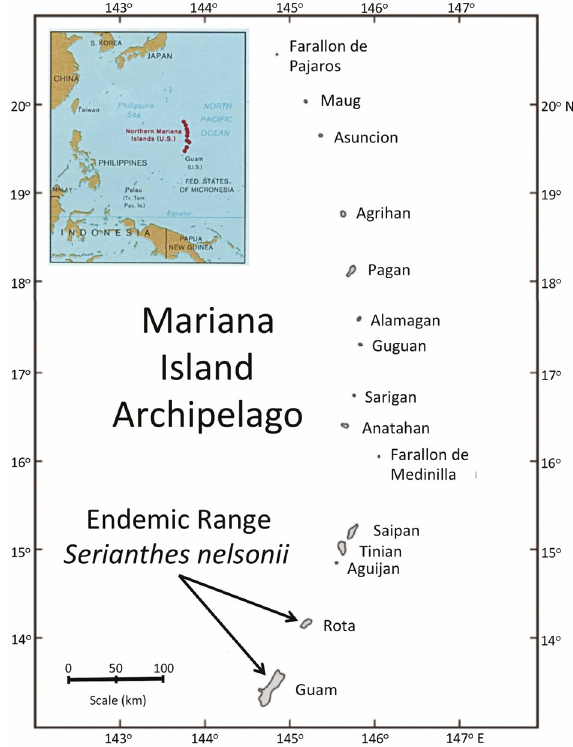
Figure 1. The Mariana Island Archipelago is comprised of the United States Commonwealth of the northern Mariana Islands and the United States Territory of Guam. The endemic range of Serianthes nelsonii is restricted to the islands of Guam and Rota.